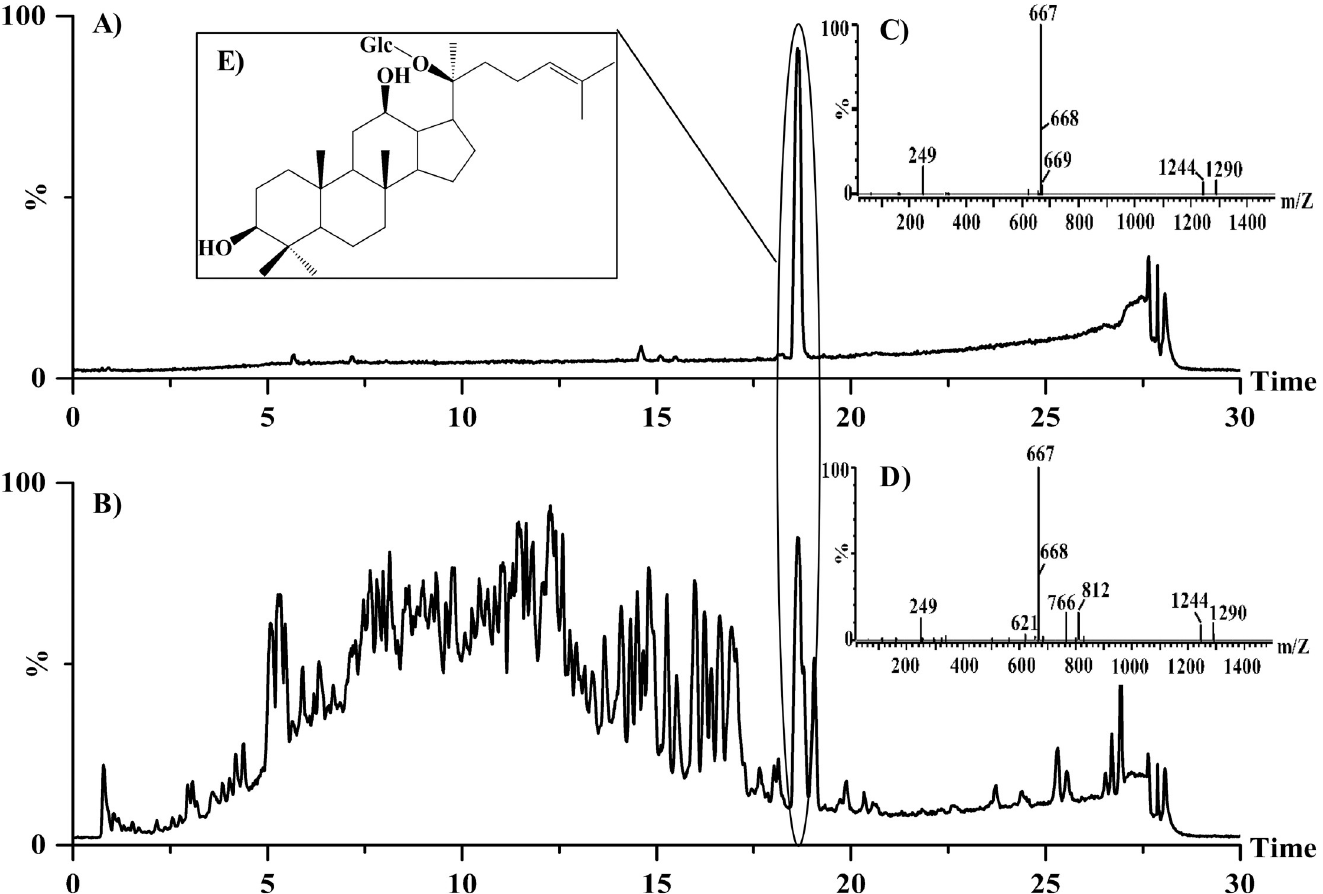
Fig 3. UPLC-Q-TOF-MS analysis of the fermented sample of JE0512. A: Total ion current chromatograms of CK standard; B: Total ion current chromatograms of JE0512 fermentation sample; C: Mass spectrum of CK standard; D: Mass spectrogram of JE0512 fermentation sample; E: The chemical structural formula of CK.